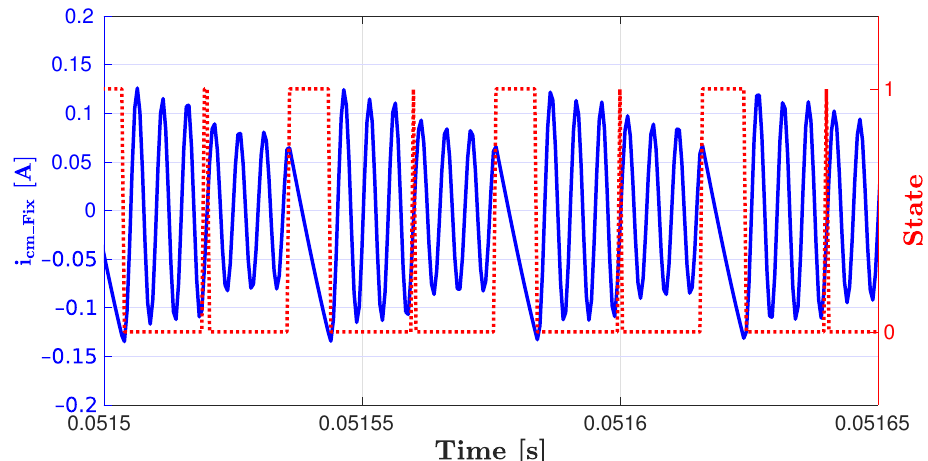
Figure 10. i cm _ Fix (blue line) evolution during Zero and Active Vectors. The zero value of the red trace represents the Zero Vector while the value 1 represents the application of any Active Vectors.